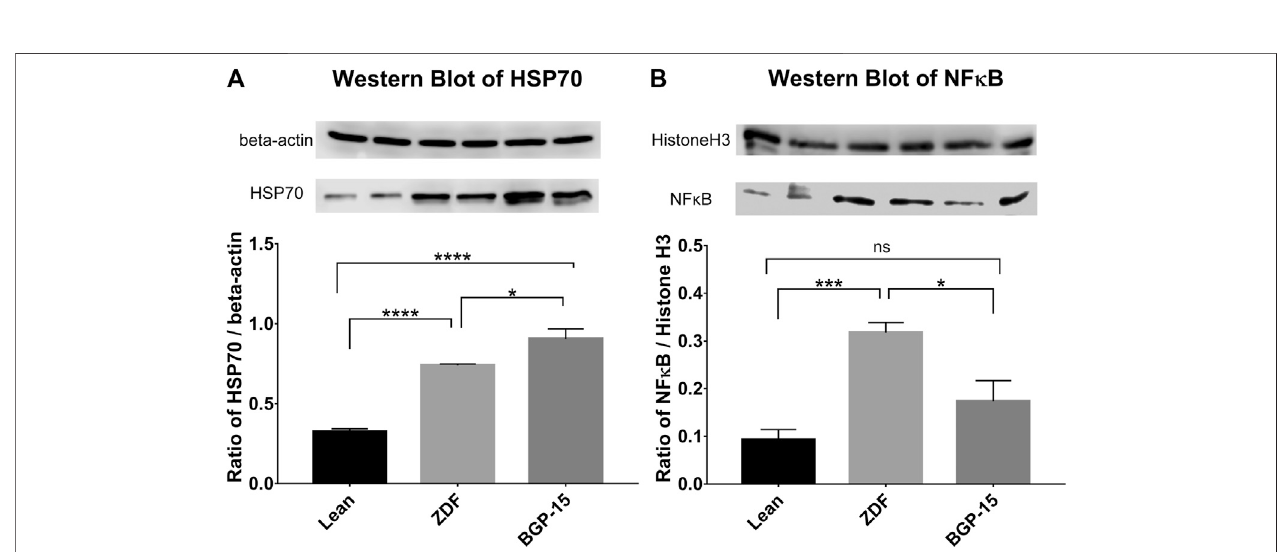
FIGURE 6 | Western blot results. (A) Expression levels of heat shock protein 70 (HSP70) in the different groups. (B) Expression levels of nuclear factor kappa B (NF κ B) in the different groups. All data are presented as group means ± standard error of the mean (SEM); * p < 0.05; *** p < 0.001; **** p < 0.0001; ns (cid:2) nonsigni fi cant. Statistical analysis was done using GraphPad Prism: after estimation of Gaussian distribution with the Shapiro – Wilk normality test, data were either analyzed with the one-way analysis of variance (ANOVA) or the nonparametric Kruskal – Wallis test.